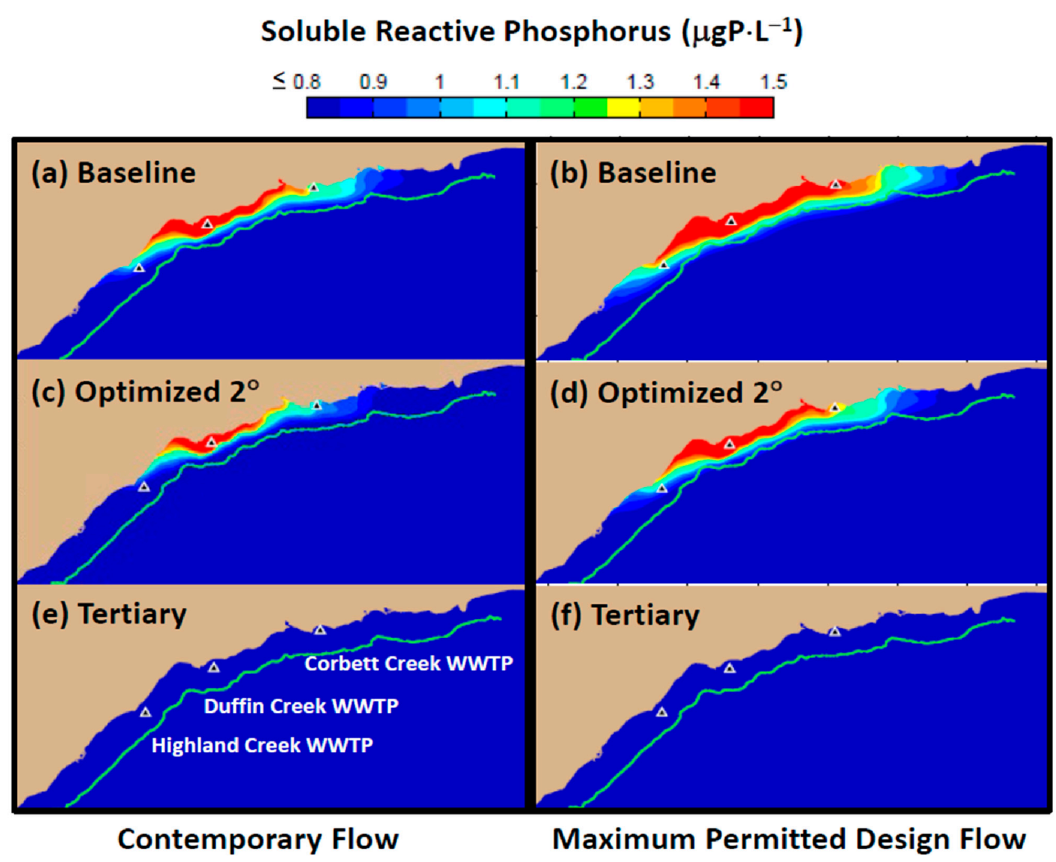
Figure 13. Sole-source simulation of the bottom water SRP footprint for the Duffin Creek WWTP under contemporary treatment (Baseline; panels ( a , b )) and two engineered treatment options (Optimized 2 ◦ , panels ( c , d ) and Tertiary, panels ( e , f )), each for contemporary and maximum permitted design